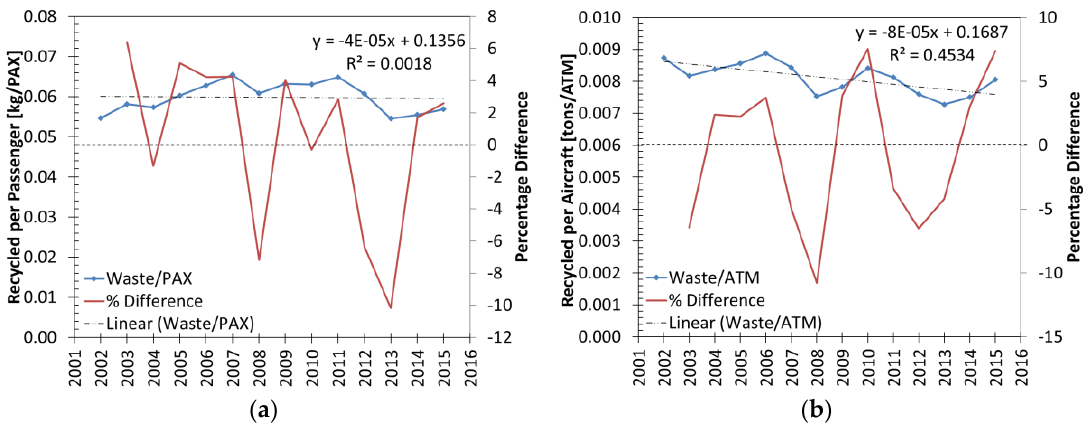
Figure 6. Recycled waste and year on year percentage difference at Kansai International Airport during 2002–2015: ( a ) per passenger; and ( b ) per aircraft movement. Source: Data derived from [60,66].